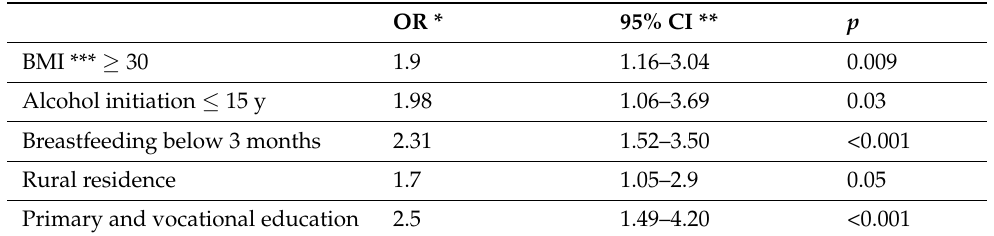
Table 3. Results of multivariate logistic